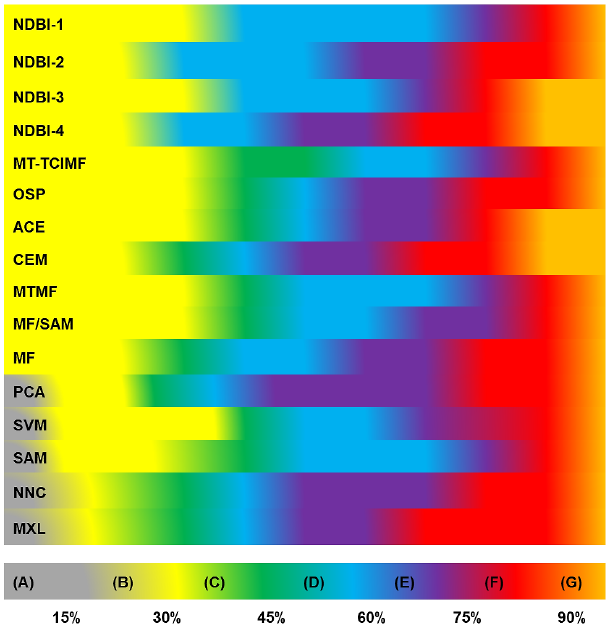
Figure 11. Percentage contribution of confounding surrounding features and/or topography in misclassification of blue ice. The figure was prepared using repeated visual inspection of the final output blue ice maps generated using the 16 different methods against PAN-sharpened WV-2 imagery and the spectral signatures of confounding features. The factors contributing to the misclassification are; (A) landmass/rocks/nunataks, (B) water bodies (supraglacial ponds/lakes, open/frozen/semi-frozen lakes/melt-lakes/freezing epishelf lakes), (C) meltwater on ice surface, (D) supraglacial debris and streams/crevasses/sastrugi/ripples (E) shadow (topography) (F) elevation (topography; low, moderate, high) (G) background ice/sporadic snow/windswept firn. The colour bar shows the distribution of contribution of land cover or topographical factors constituting the total misclassification imparted by each method. Seven contributing factors caused varying amounts of misclassification for different methods. These variations are depicted using approximate percentage values using colours. Length of the colour bar shows the percentage while the colour shows the contributing factor.